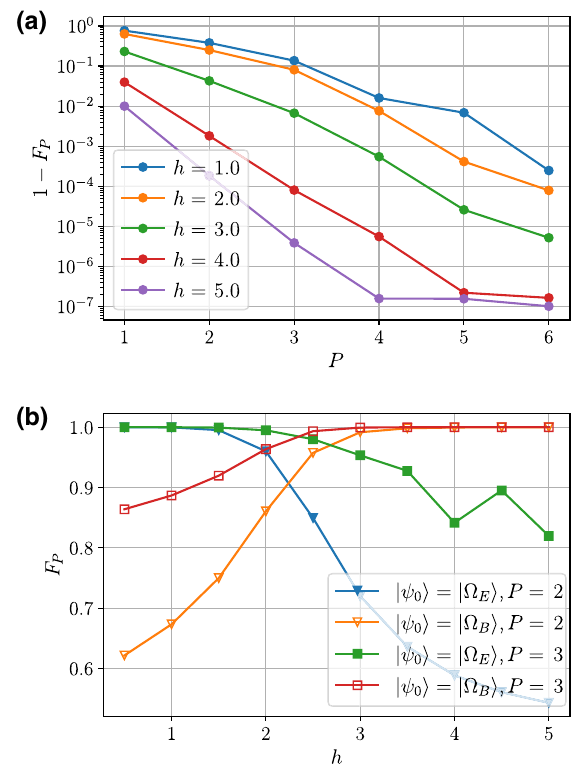
FIG. 7. (a) Infidelity versus the number of QAOA layers P for L = 3 and several values of the magnetic coupling h . Data cor- respond to the best out of ten results obtained in the two-step optimization, performed on a state initially prepared in the toric code ground state | (cid:5) B (cid:3) ; hence, the convergence is now faster for larger couplings h . (b) Comparison between two-step QAOA performance by starting from the electric and magnetic ground states: we plot the fidelity versus magnetic coupling h at fixed values of P . Here P only takes into account the number of QAOA layers with parameterized gates, while it does not include the computational overhead for the preparation of | (cid:5) B (cid:3) , compared to preparing | (cid:5) E (cid:3)